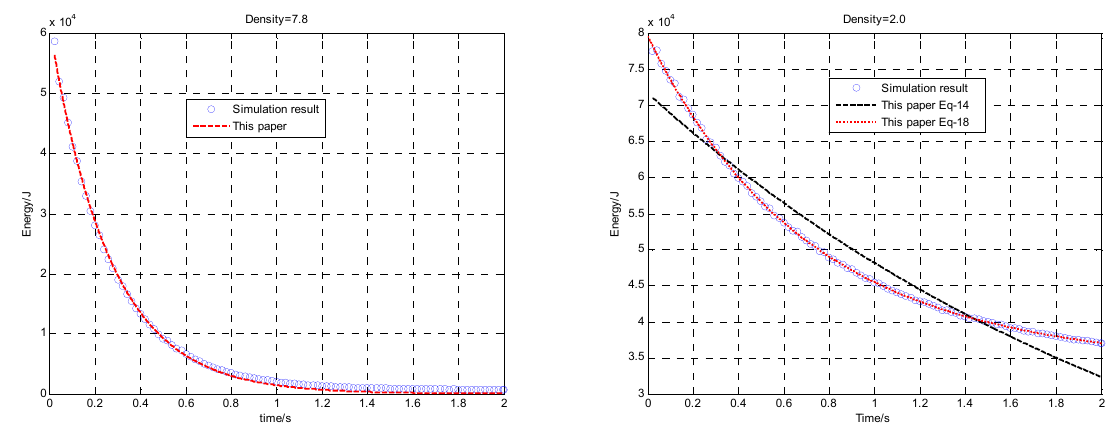
Figure 37. The plot of energy vs. time at the density = 7.8, 2.0, respectively. Table 6. Plastic kinematic model, E = 210 GPa,